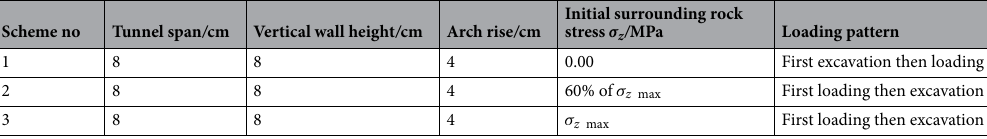
Table 4. Testing scheme